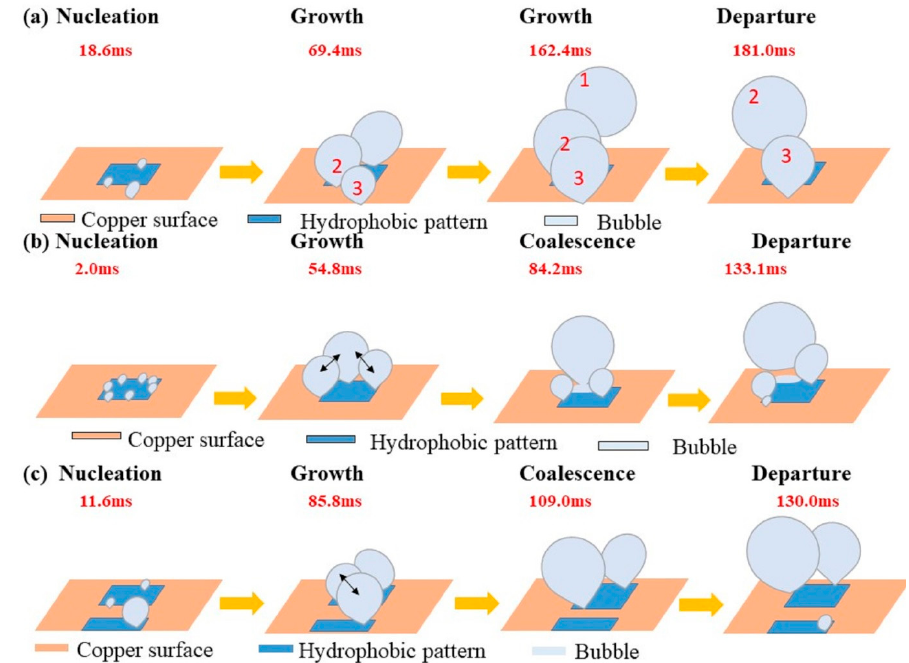
Figure 4. Schematic of different bubble development mechanisms at a constant heat flux of 7 kW/m 2 ( a ) isolated development of bubble; ( b ) internal coalescence of bubbles on a pattern; ( c ) inter coalescence of bubbles on the neighboring pattern in circumferential direction.